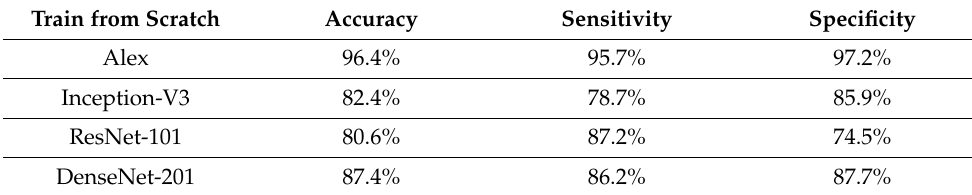
Table 2. The performances of various convolutional neural networks trained from scratch. Train from Scratch